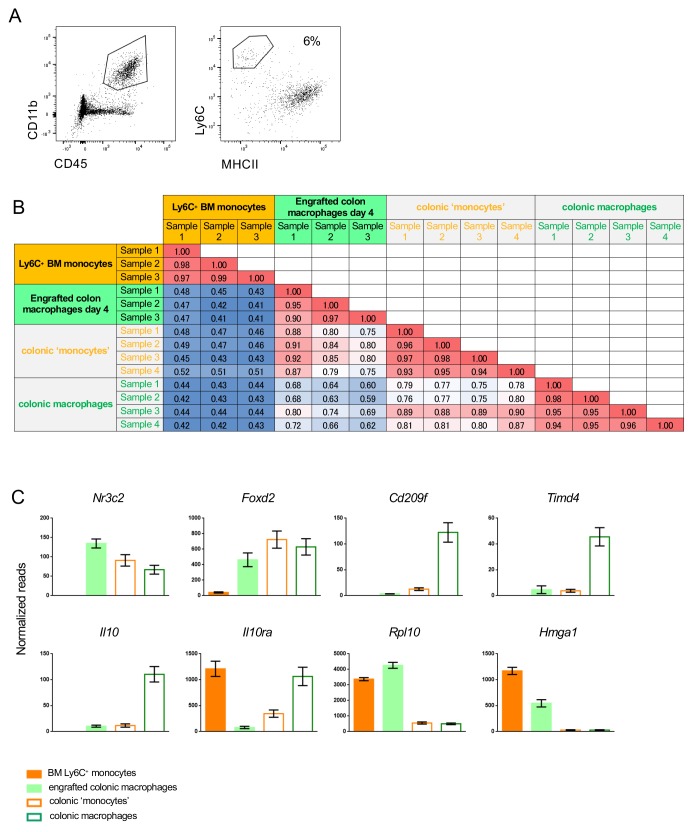
Comparison of graft and engrafted cells to recent monocytic infiltrates in the colon, identified by their Ly6C surface expression.(A) Representative flow cytometric analysis of colonic myeloid cells. Recent monocytic infiltrates and macrophages in the colon were defined as CD45+ CD11b+ Ly6C+ MHCII- and CD45+ CD11b+CD64+ Ly6C- MHCII+ cells, respectively and sorted accordingly for RNAseq. (B) Representative correlation coefficients between indicated cell populations (Suppl. file 1, data sets 3, 4, 5, 6). (C) Representative genes differentially expressed between monocyte graft, engrafted cells (d4), early monocyte infiltrates and resident macrophages.